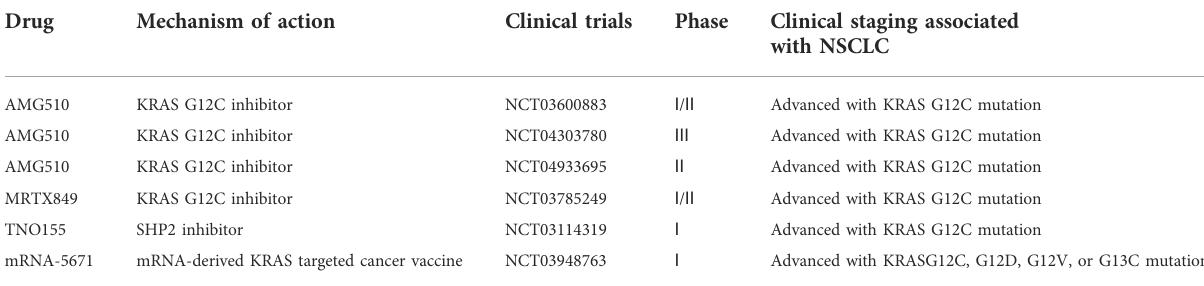
TABLE 2 Ongoing clinical trials related to KRAS mutated